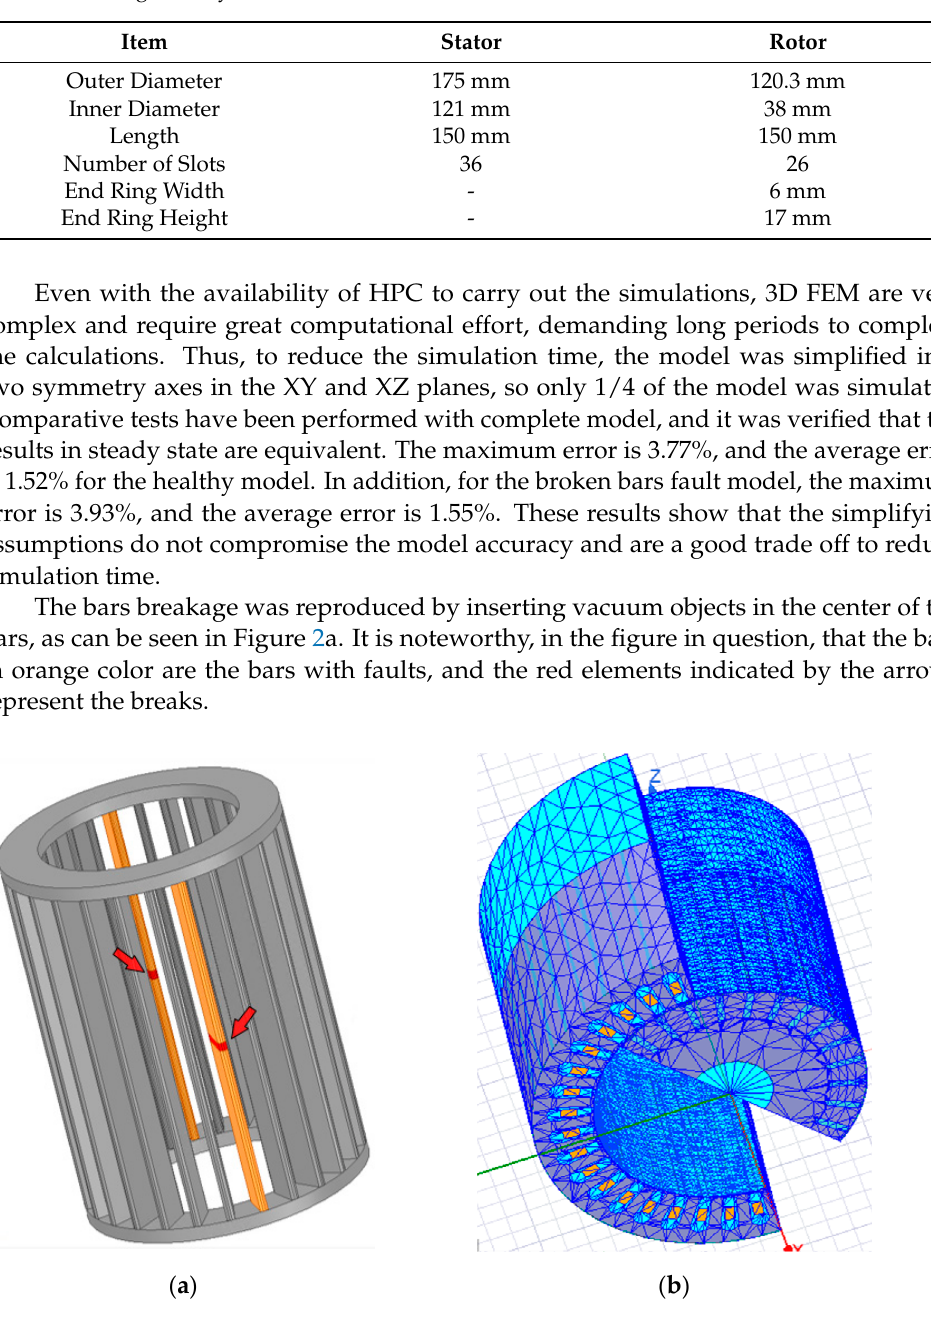
Table 1. Model geometry data.